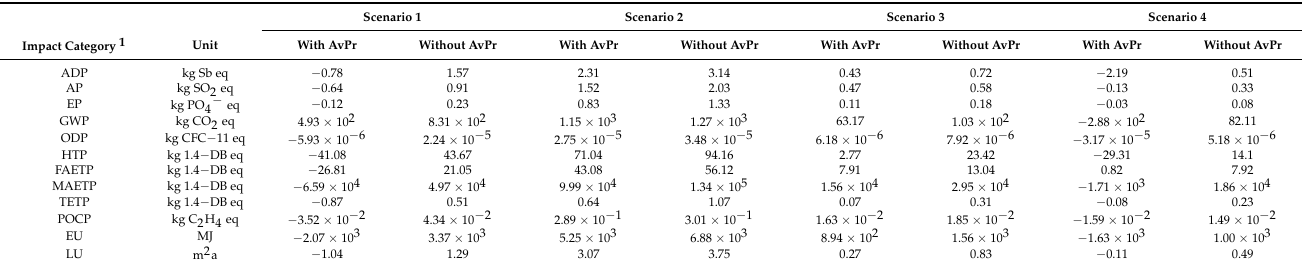
Table 3. Comparison of the characterization results at 1 metric ton of kitchen waste treated, with and without avoided products (AvPr). Scenario1 Scenario2 Scenario3